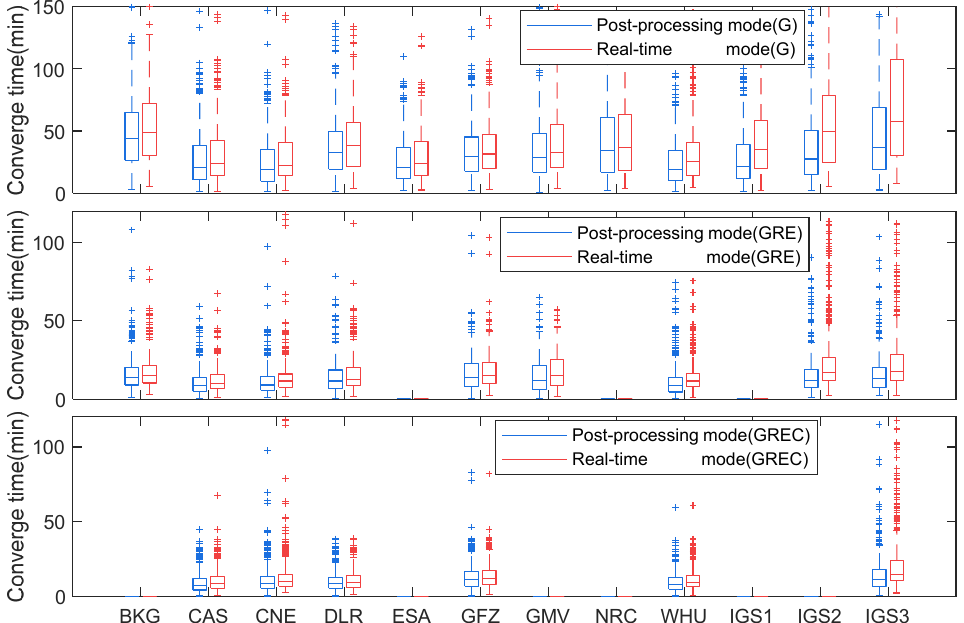
Figure 10. The convergence time of kinematic PPP using different SSR products for 16 IGS stations. The median convergence time of kinematic PPP in post-processing mode with GPS only for different real-time products ranged from 19.0 min to 44.0 min, while it ranged from 22.5 min to 58.0 min in real-time mode. The large latency had a more negative effect